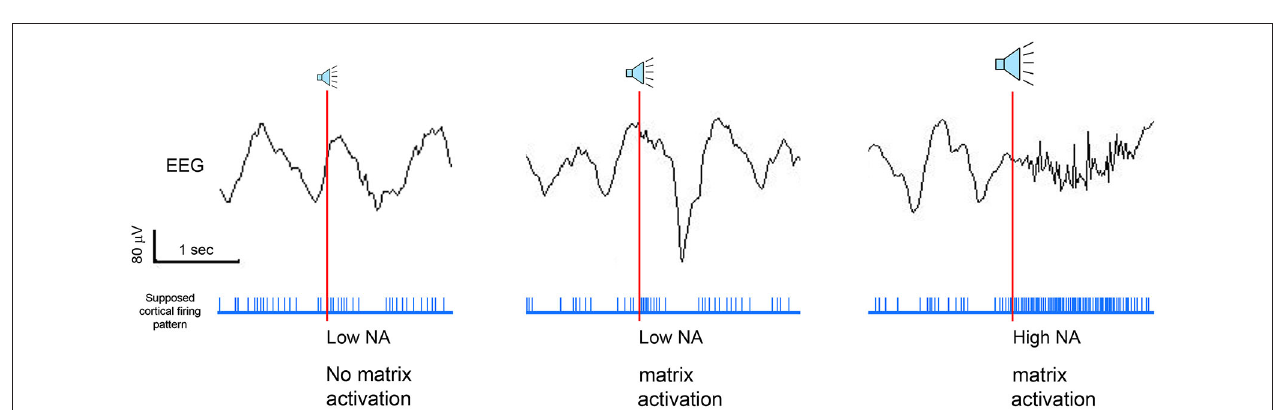
FIGURE 4 | Schematic representation of the organization of the ascending acoustic pathways and relative targets in the thalamus and the cerebral cortex . ICx: shell of the inferior colliculus; MRF: midbrain reticular formation; Sag: Sagulum; ST: spinothalamic tract;